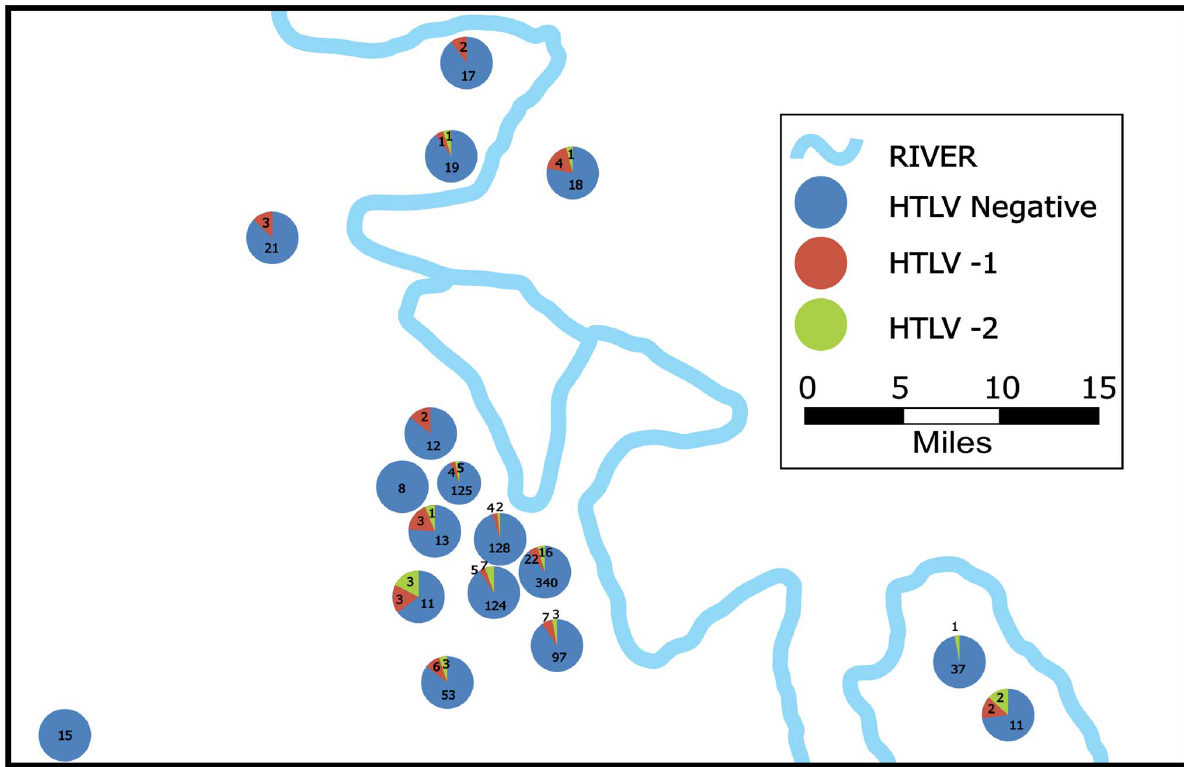
Figure 1. Frequency of HTLV-1 and -2 infections per community in the Ucayali region.